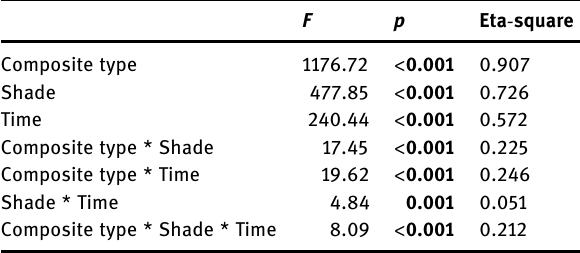
Table 2: E ff ect of composite type, shade, and time, and the inter - actions on color matching F p Eta -